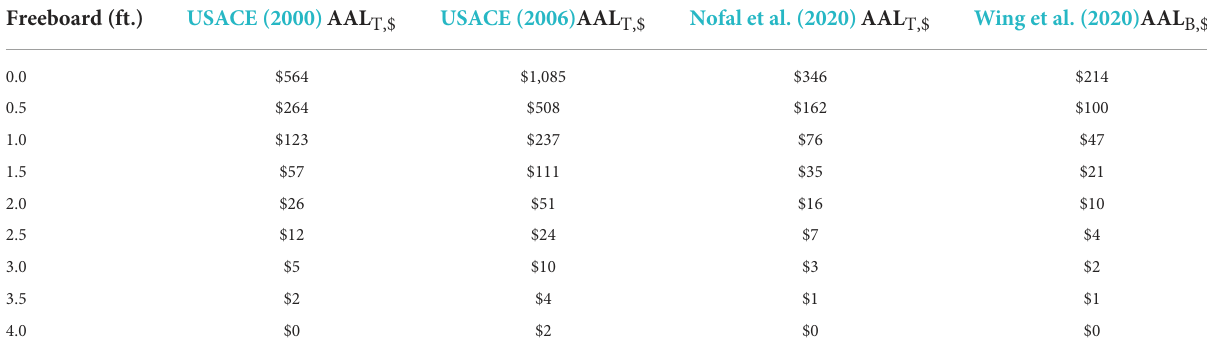
TABLE 6 As in Table 4, but for damage initiation point of 0 ft relative to FFH, and including Wing et al. (2020). Freeboard